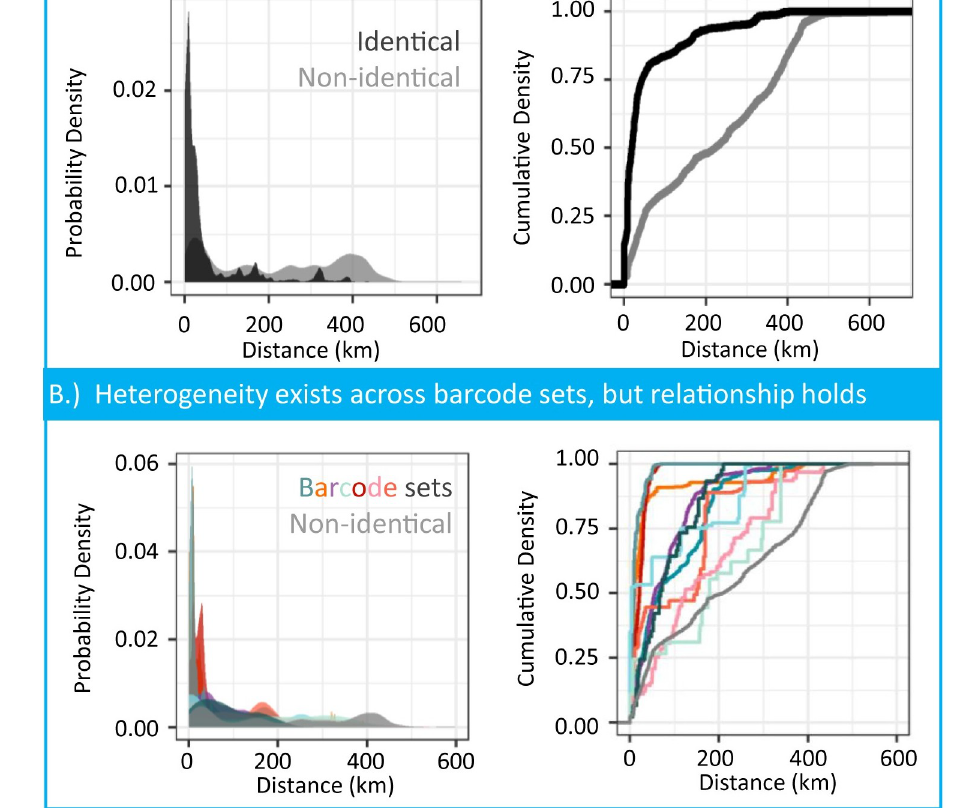
Fig 2. Distance density estimates of pairwise similarity for identical and non-identical barcodes. A.) Pairwise comparisons of identical barcodes in black (n = 10, 695) to a null of non-identical barcodes in gray (n = 79, 830). This distribution at 400 kilometers is the max distance between sampled cases along the Chari River. This enrichment of pairwise sample distance around 400 kilometers should not be considered the transmission upper bound. B.) The number of comparisons for each barcode are the unique pairs of all worms sharing that barcode identifier. The null distribution in gray of non-identical barcodes is subset to only include comparisons where one of the common barcodes must be found in the pair (n = 56,